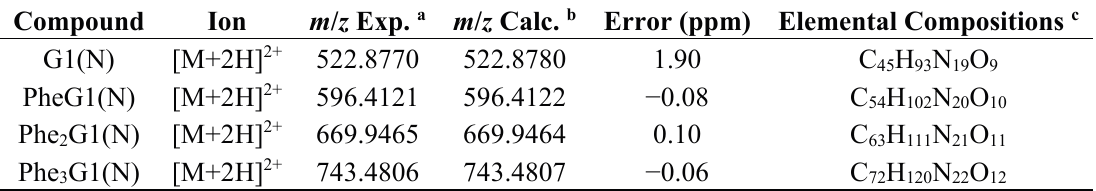
H N O 45 93 19 9 H N O 54 102 20 10 C H N O 72 120 22 12